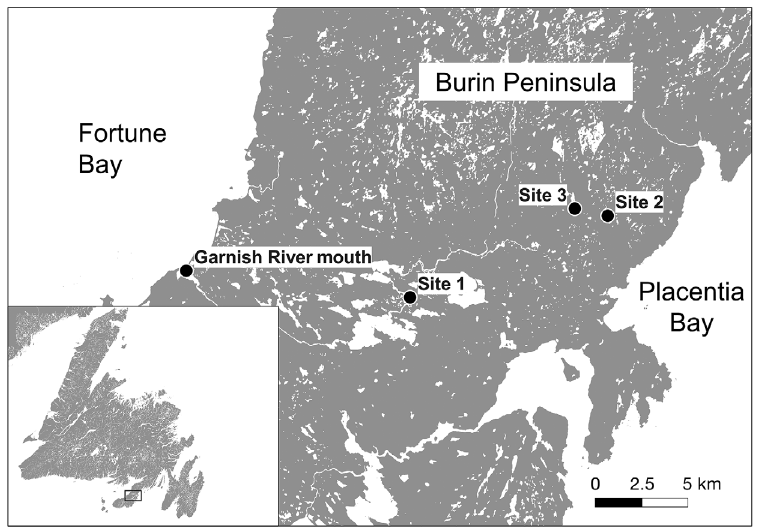
Fig. 1. The 3 tributary study sites of the Garnish River, Newfoundland, Can- ada, used for the release and recapture experiment with Atlantic salmon. Inset: the island of Newfoundland; box: general study area. Map created in QGIS; map style created in Mapbox; data by OpenStreetMap under